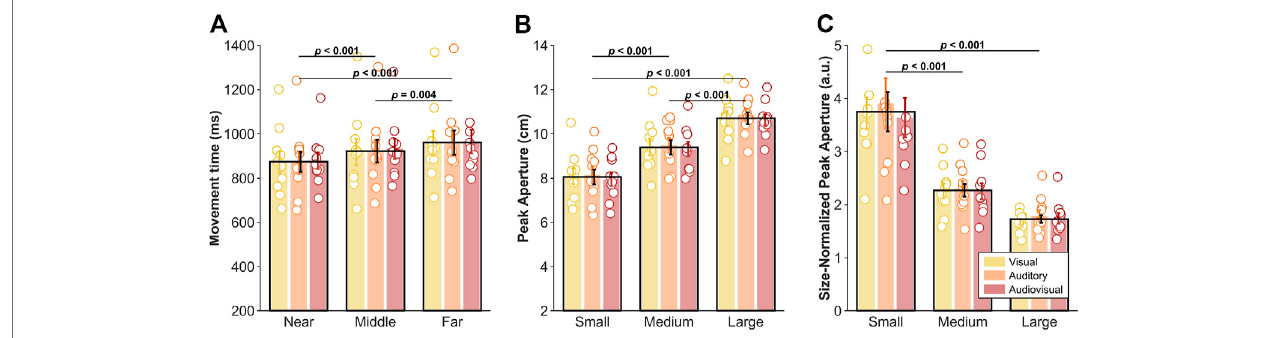
FIGURE4| Study1.Effectsof (A) objectdistanceonmovementtime, (B) objectsizeonpeakaperture,and (C) objectsizeonsize-normalizedpeakaperture.Error bars indicate ± 1 SEM ( n (cid:1) 10). Data calculated across all levels of sensory feedback for each participant.